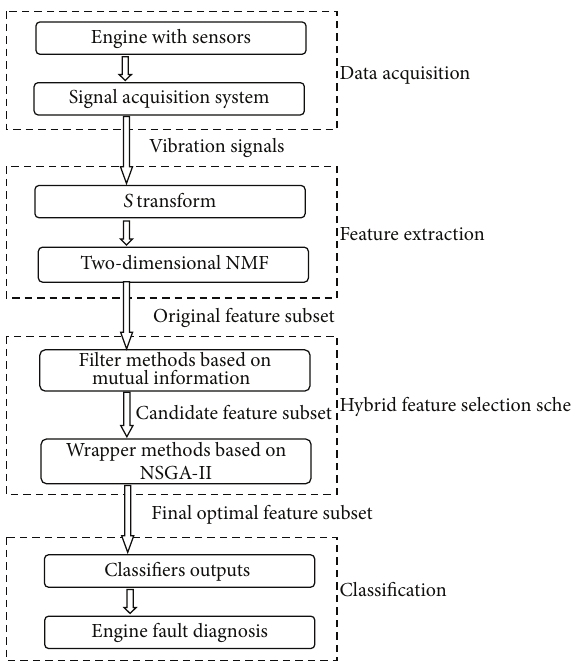
Figure1:Flowchartofthepresentedfeatureextractionandselection scheme for intelligent engine fault